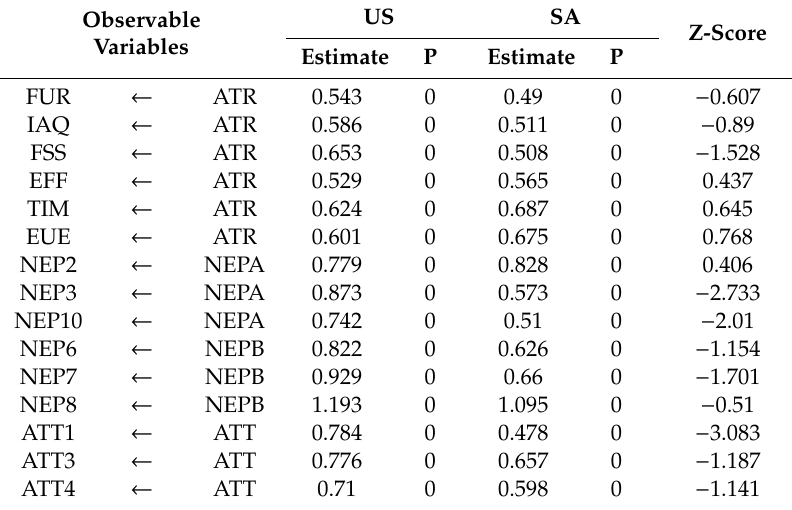
Table 7. Statistical di ff erences in observable variables between the US and SA.